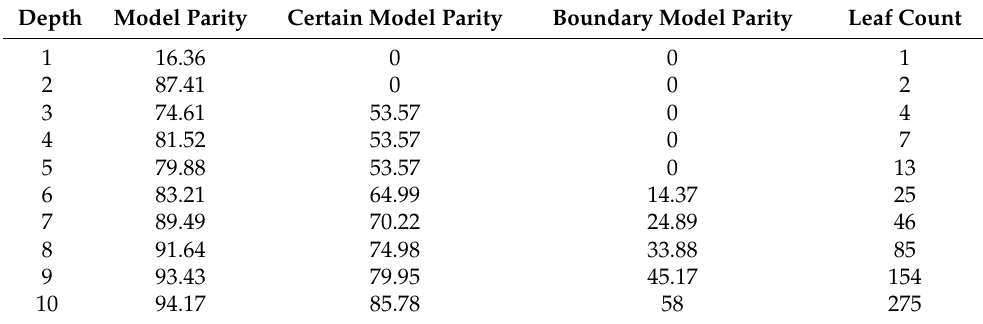
Table 8. Evaluation of the interpretable models for the Diabetes dataset generated by MTRE-PAN at depths ranging from 1 to 10.